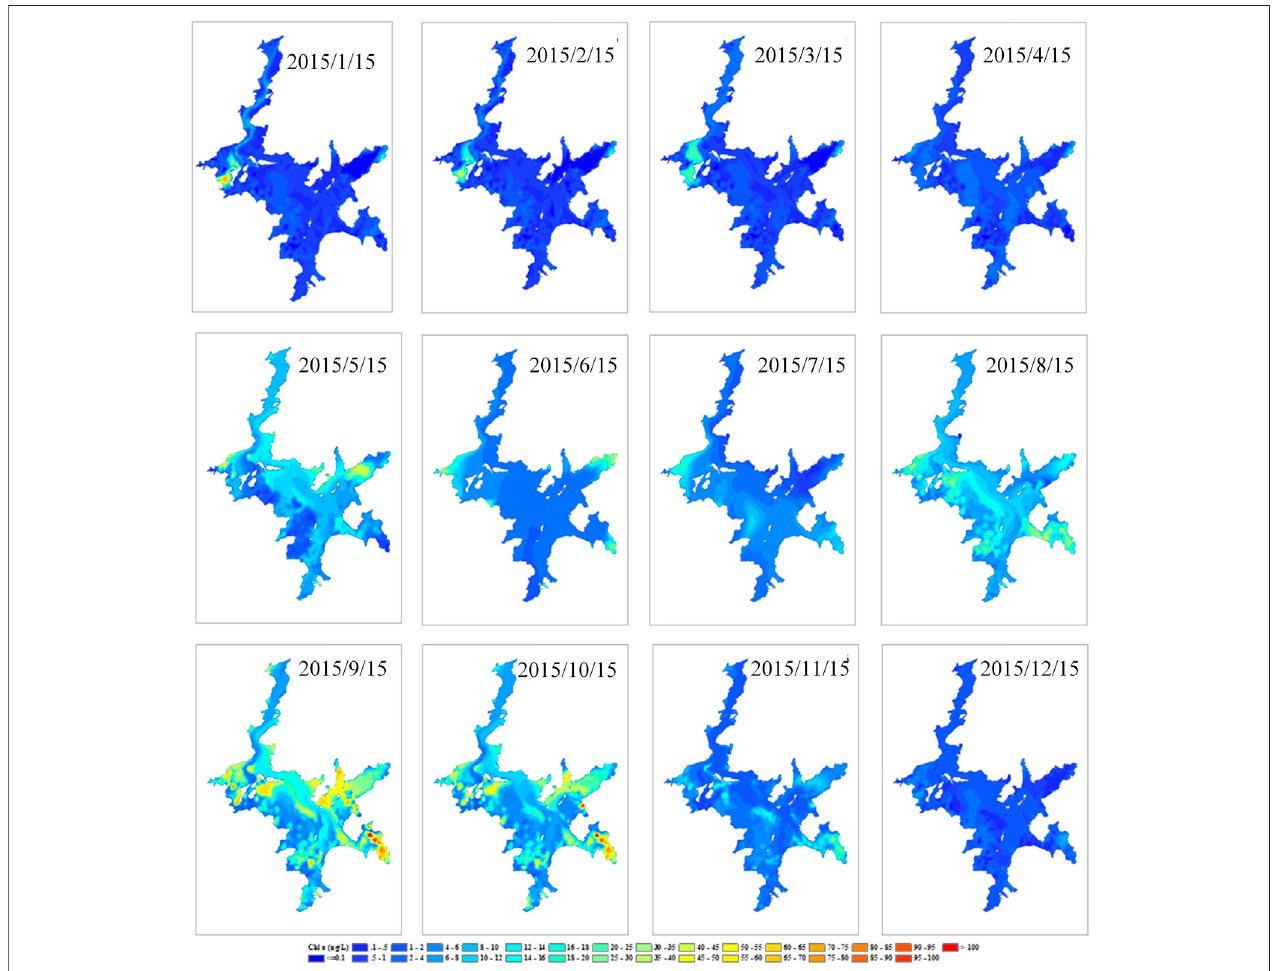
FIGURE 5 | Spatiotemporal distributions of the simulated Chl a concentrations in Lake Poyang in 2015.